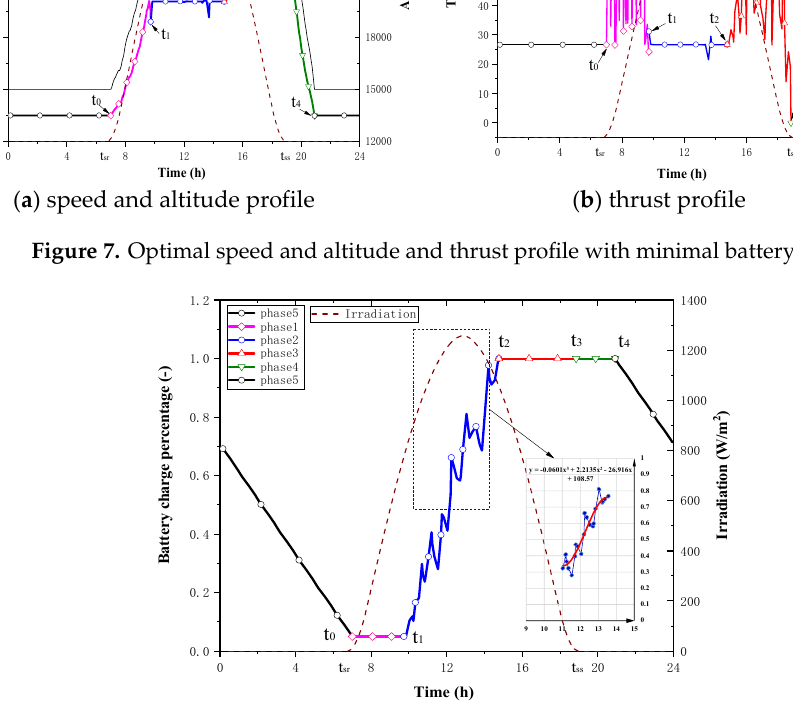
Figure 8. Optimal battery charge percentage profile with minimal battery mass.